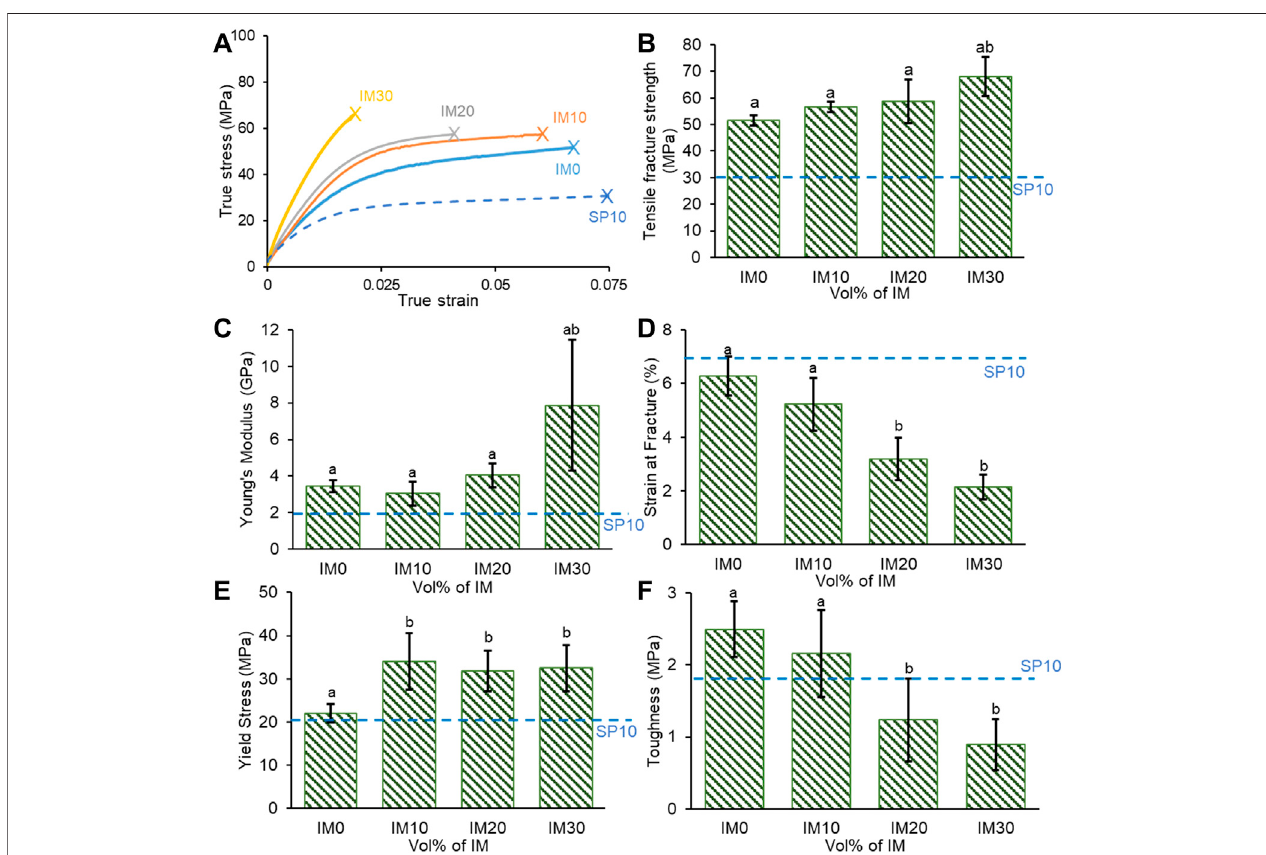
FIGURE 4 | Tensile mechanical properties of the mSLA-printed nanocomposites: (A) representative true stress vs true strain curves, (B) tensile fracture strengths (ultimate tensile strengths), (C) Young ’ s moduli, (D) strains-at-fracture, (E) yield strength, and (F) toughness. For panels (B – F) , data are presented as mean ± SD ( n = 7 specimensofeachcomposition).One-wayANOVAandTukey ’ smultiplecomparisontestwereusedforstatisticalanalysis.Differentsmall-caselettersindicatestatistical signi fi cance at p < 0.05. The dotted blue line represents the corresponding values of SP10, an AESO/PEGDA/nHA based nanocomposite from our previous work (Mondal et al.,